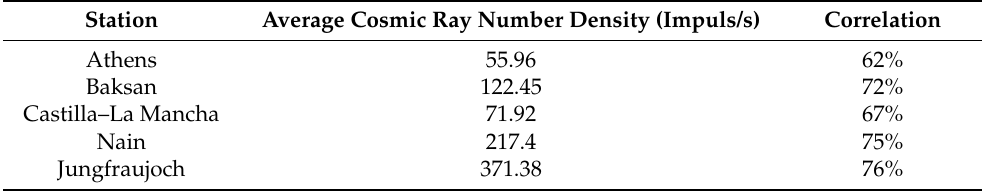
Table 6. Average cosmic ray number density and correlation values.